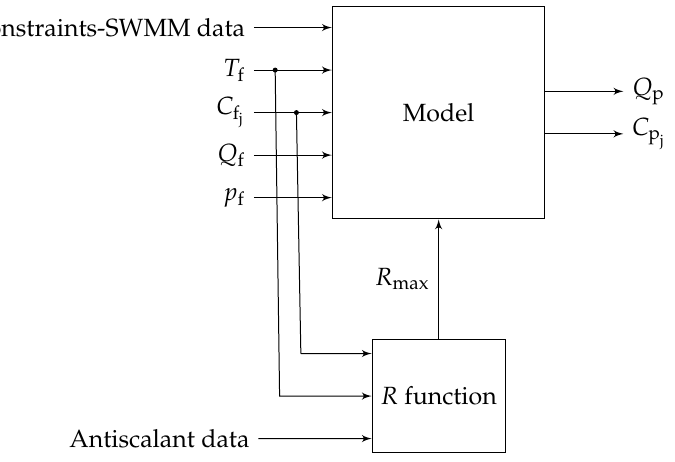
Figure 2. Inputs and outputs of the calculation